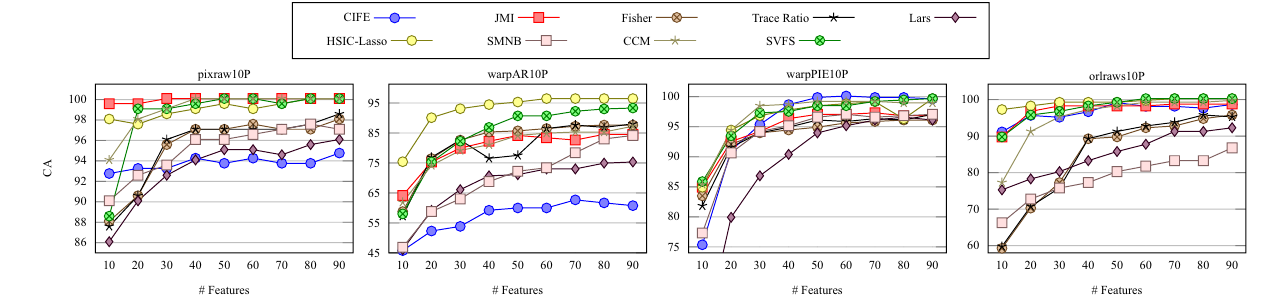
Figure 3. Average classification accuracy of feature selection by CIFE, JMI, Fisher, Trace Ratio, Lars, HSIC- Lasso, SMNB, CCM and SVFS over 10 runs on benchmark face image datasets.